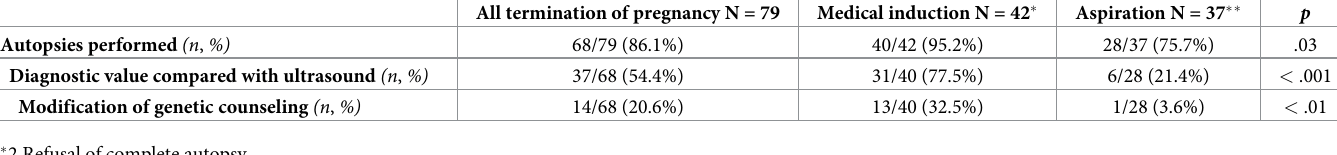
Table 2. Value of fetal autopsy, globally and by method of